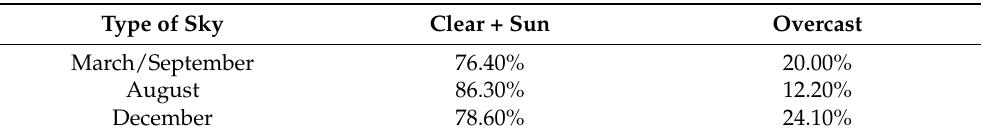
Table 1. The probabilities of occurrence for overcast and clear sky in Seville (Spain). The State Meteorological Agency, AEMET. Source: the